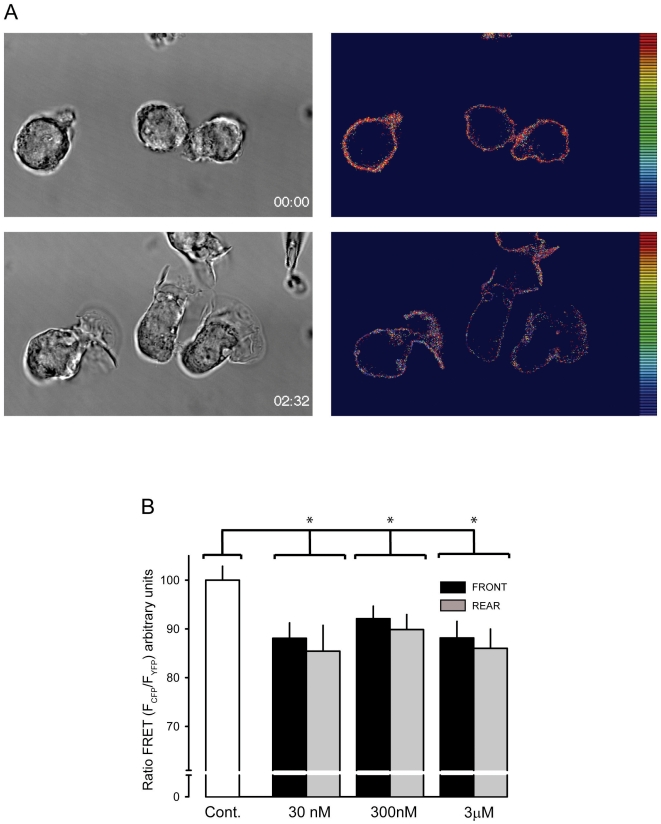
FRET efficiency of α2AAR-YFP/CFP in migrating cells.(A) Selected frames from Movies S4 just after insertion of the micropipette dispensing 300 nM UK 14'304 (0 sec, upper images) and after 152 sec (2:32, lower images). Ratio FRET of THP-1 cells expressing α2AAR-YFP/CFP was measured as described in Methods. The false color shows FRET efficiencies. Gray, corresponding phase image. (B) Quantitative analysis of FRET efficiencies at the beginning (Cont., white bar) and 2–3 min after stimulation measured at the front (black bar) and rear (grey bar). Mean values of 3 cells from 3 independent experiments (30 nM and 300 nM UK 14'304) and 3 cells from 2 experiments for 3 µM UK 14'304. Stars indicate statistical relevance of p<0.0001 (T-test).